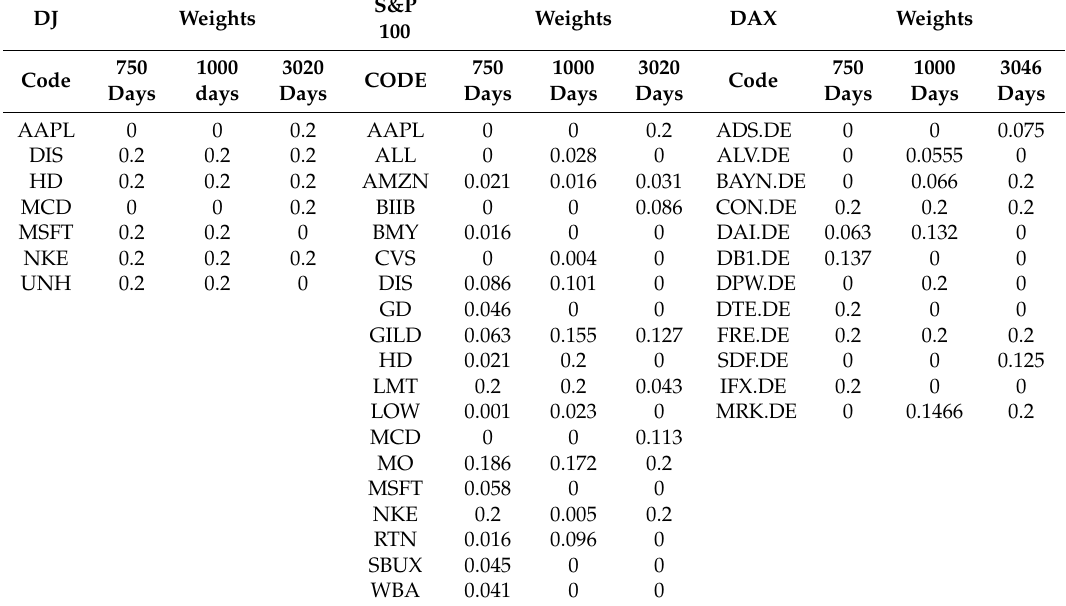
Table A1. Weights of SSD constrained portfolios at the last month of the out-of-sample period and weights with all in-sample data. Stocks with zero positions for all periods (750, 1000 and 3020 days for DJ and S&P 100 and 750, 1000 and 3046 days for DAX) are skipped.